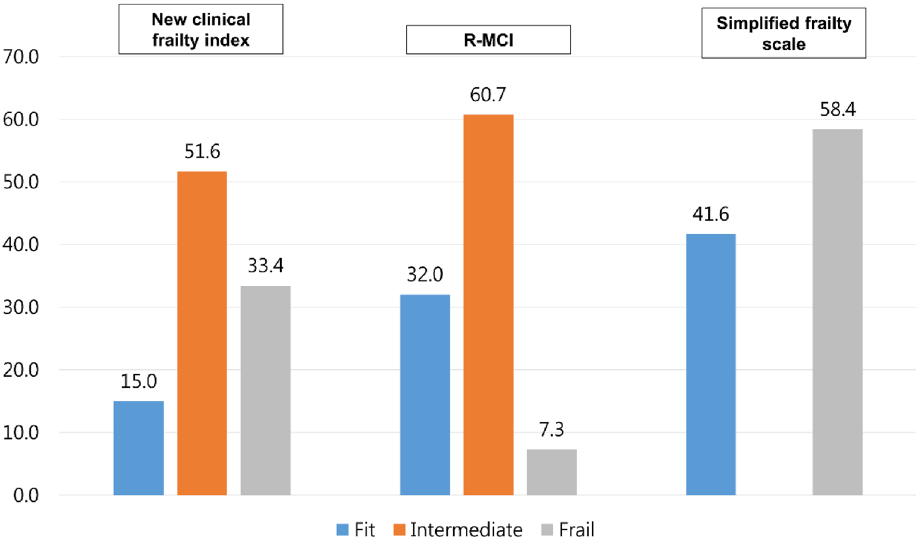
Figure 1. Proportion of patients classified in each frailty group according to the frailty